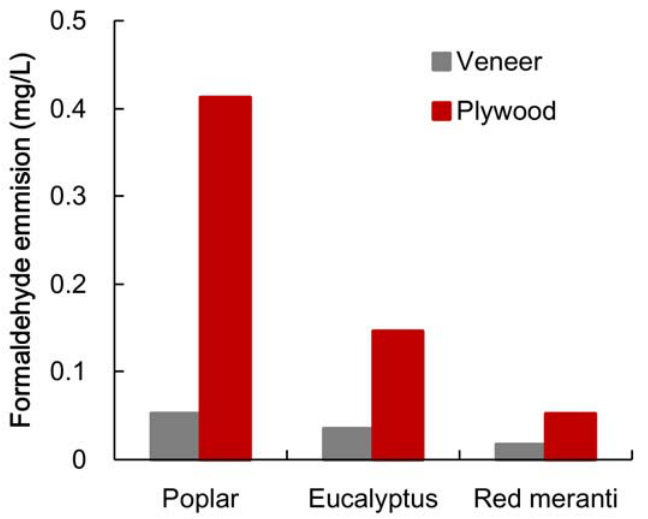
Figure 1. Formaldehyde emission of veneer and